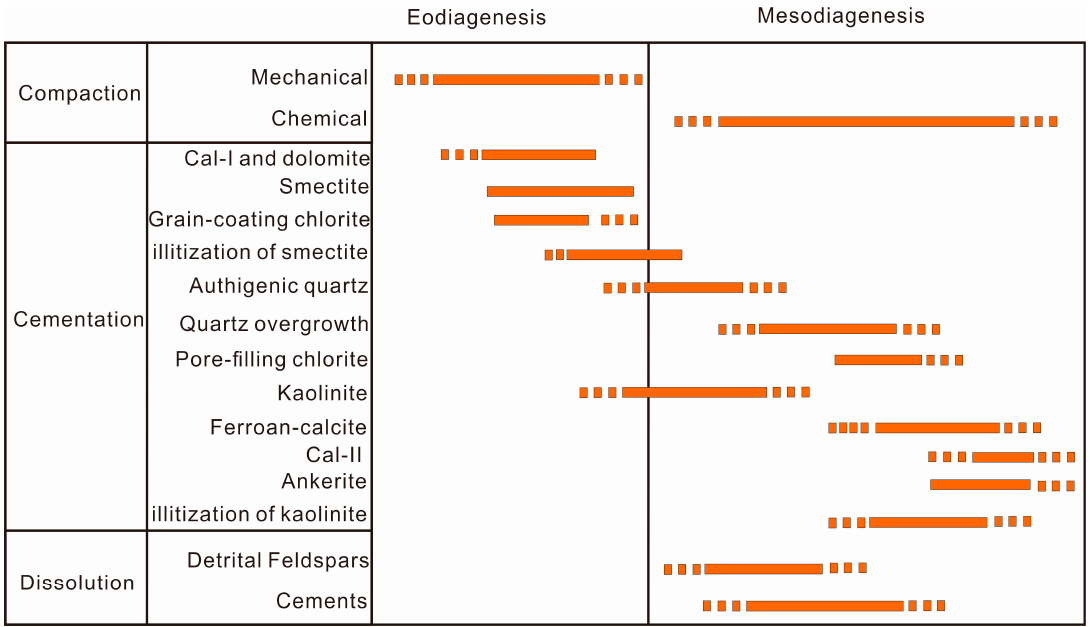
Figure 14. Paragenetic sequences of the Lulehesandstone.